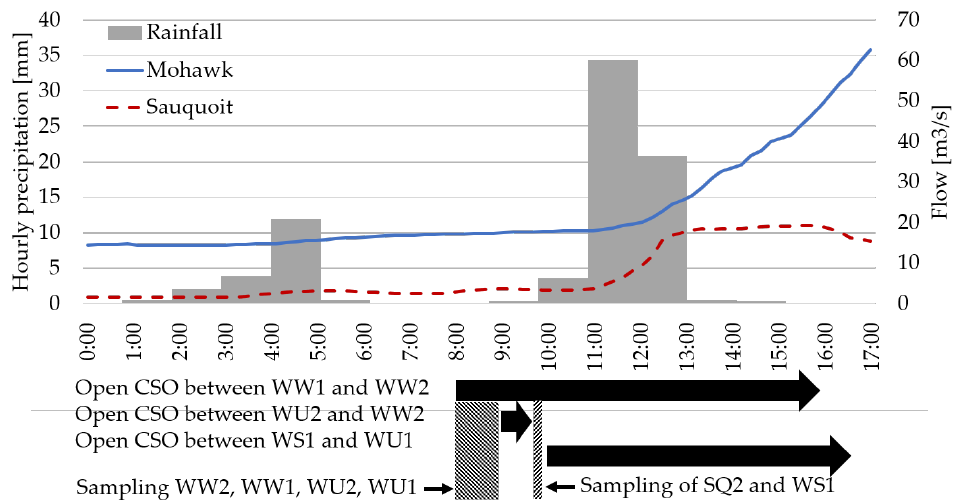
Figure 4. Plot of rainfall and flow in the Mohawk and Sauquoit Creek as a function of time on 17 July 2019. Timeline of CSO activation and sampling of specific sites is shown below to demonstrate collection of samples prior to activation of CSOs upstream.